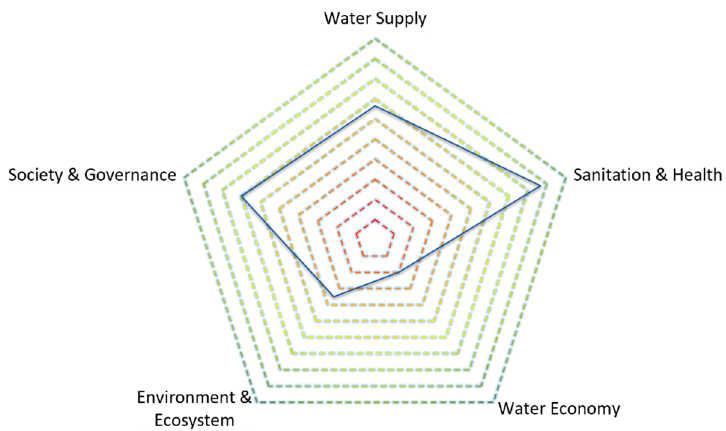
Figure 3. Islamabad’s UWSI Indicators.